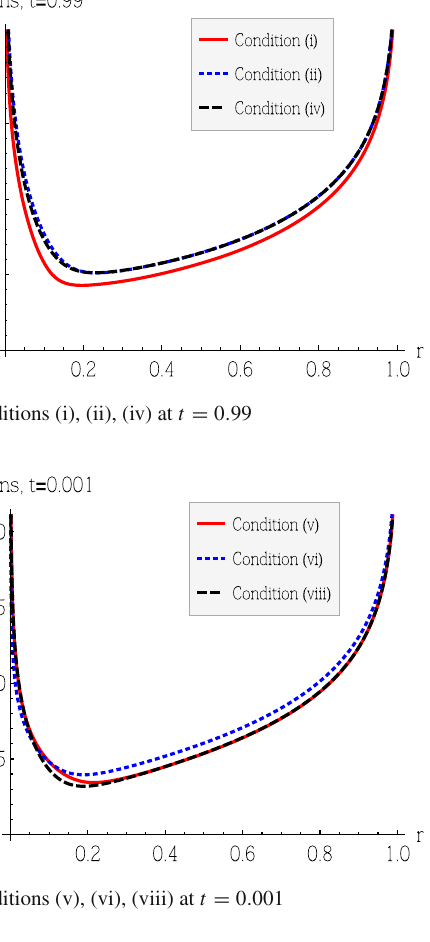
Fig. 16 Conditions (v), (vi), (viii) at t = 0 . 001